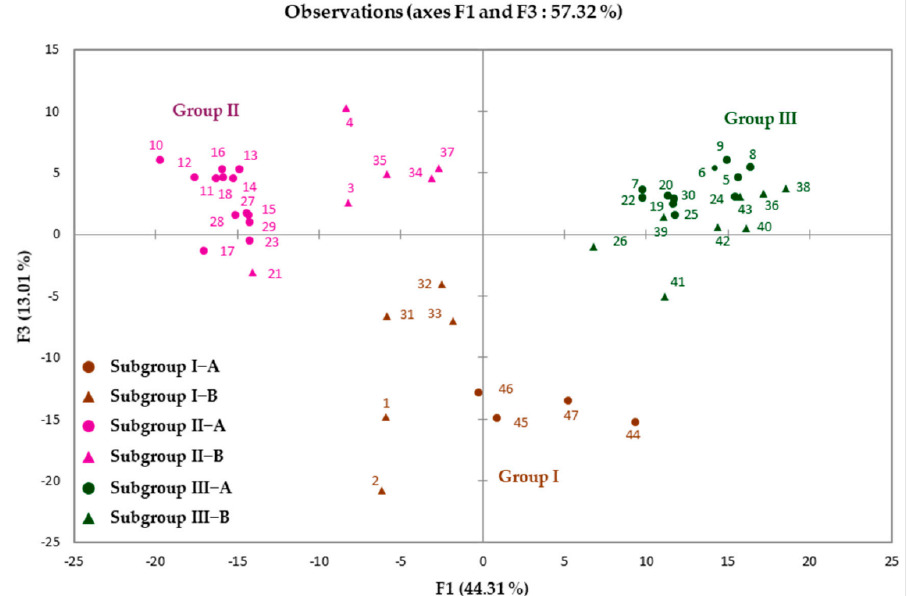
Figure 2. Principal component analysis (PCA) of the 47 leaf oil samples from I. dewevrei